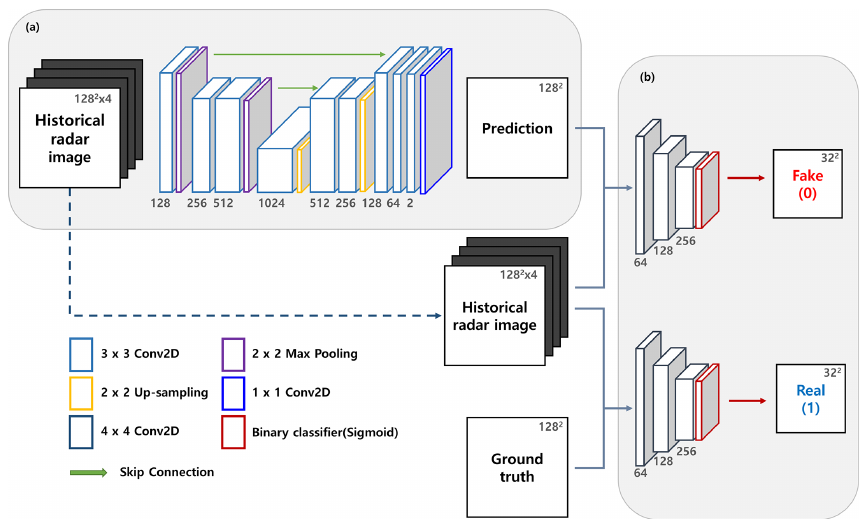
Figure 2. Model architecture consists of (a) the generator and (b) the